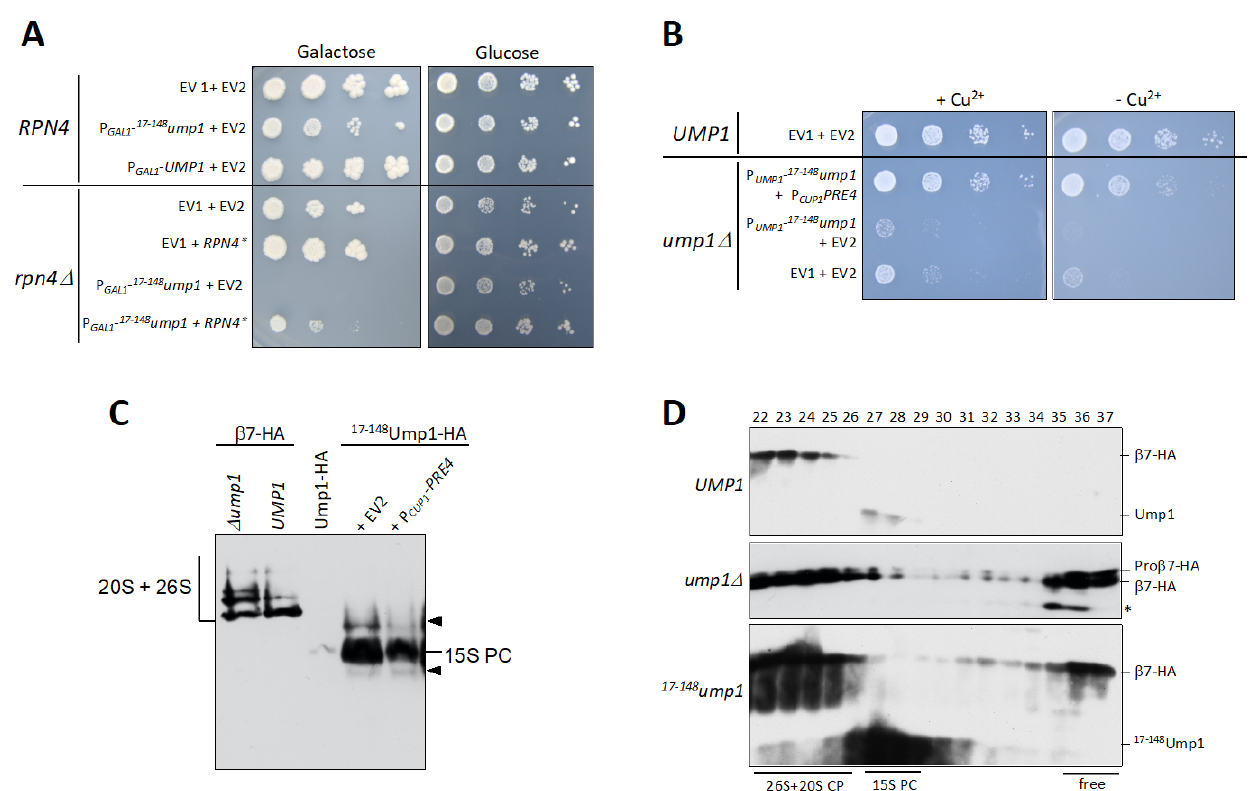
Figure 2. Toxicity of 17–148 Ump1 is suppressed by overexpression of PRE4 / β 7. ( A ) Cells lacking transcription factor Rpn4 are hypersensitive to 17–148 Ump1. Wild-type ( RPN4 ) or rpn4 ∆ cells were transformed either with an empty vector (EV1) or with plasmids encoding either full-length Ump1 or 17–148 Ump1, synthesis of which was induced by induction of the P GAL1 promotor on galactose media. At the same time, the cells were co-transformed either with another empty vector (EV2) or with a plas- mid expressing a stable version of Rpn4* [25]. Note that rpn4 ∆ cells constitutively express endogenous Ump1. Ump1 ∆ could not be used here because it causes synthetic lethality together with rpn4 ∆ [20]. Serial dilutions of cells were spotted on plates either containing galactose or glucose as carbon source and incubated at 30 ◦ C for 3 days or 2 days, respectively. ( B ) Overexpression of PRE4 encoding the β 7 subunit suppresses growth defect from cells expressing 17–148 Ump1. Wild-type ( UMP1 ) or ump1 ∆ cells were either transformed with an empty vector (EV1) or with a plasmid encoding 17–148 Ump1 expressed from the native P UMP1 promoter. At the same time, the cells were co-transformed either with another empty vector (EV2) or with a high-copy (2 µ -based) plasmid expressing PRE4 from the copper-inducible P CUP1 promoter. Serial dilutions of cells were spotted on selective glucose plates either with or without 100 µ M CuSO 4 , and incubated at 30 ◦ C for 2 days. ( C ) Overexpression of full-length β 7 reduces the amount of accumulated 15S PC containing 17–148 Ump1. Shown is a native gel analysis of proteasome complexes. Left part, ump1 ∆ or wild-type ( UMP1 ) cells with β 7-HA. Right part, 17–148 Ump1-HA expressing cells transformed either with an empty vector or with a plasmid overexpressing PRE4 (same as in ( B )). Complexes with HA-tagged proteins were detected by anti-HA Western blotting. Positions of 15S PC as well as 20S and 26S particles are indicated. Arrowheads point to two additional complexes detected in extracts from 17–148 Ump1-expressing cells. Note that high levels of 15S PC accumulate in the latter cells in comparison with otherwise wild-type cells expressing Ump1-HA (middle lane). ( D ) Free β 7 subunit accumulates in ump1 ∆ or 17–148 ump1 cells. Gel filtration analysis of complexes present in cells expressing either full-length Ump1-HA, no Ump1 ( ump1 ∆ ) or 17–148 Ump1-HA as well as β 7-HA. Fractions from 22 to 37 were analyzed by SDS-PAGE and anti-HA Western blotting. *, degradation